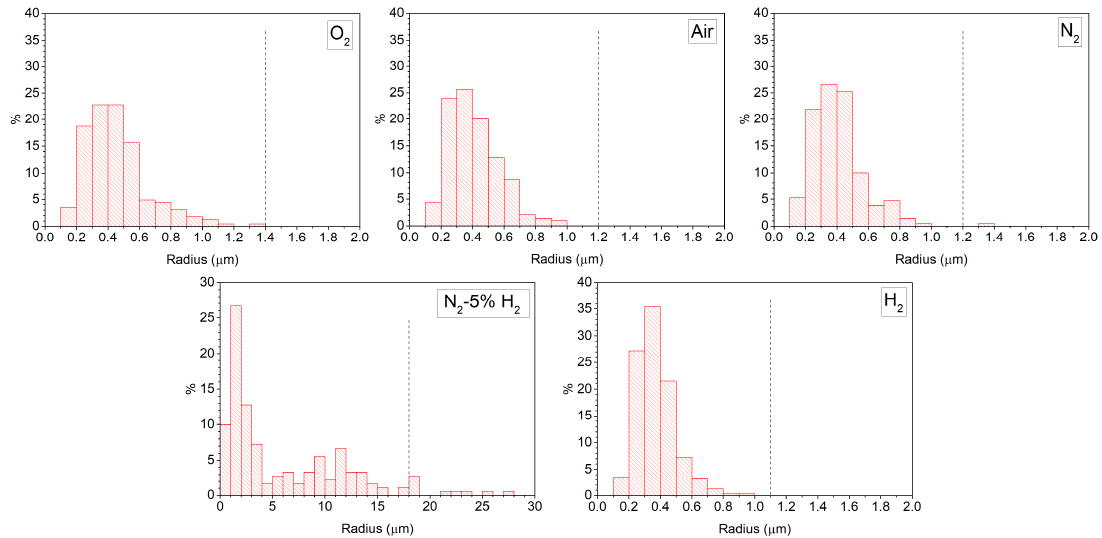
◦ C for 1 h in di ff erent atmospheres are